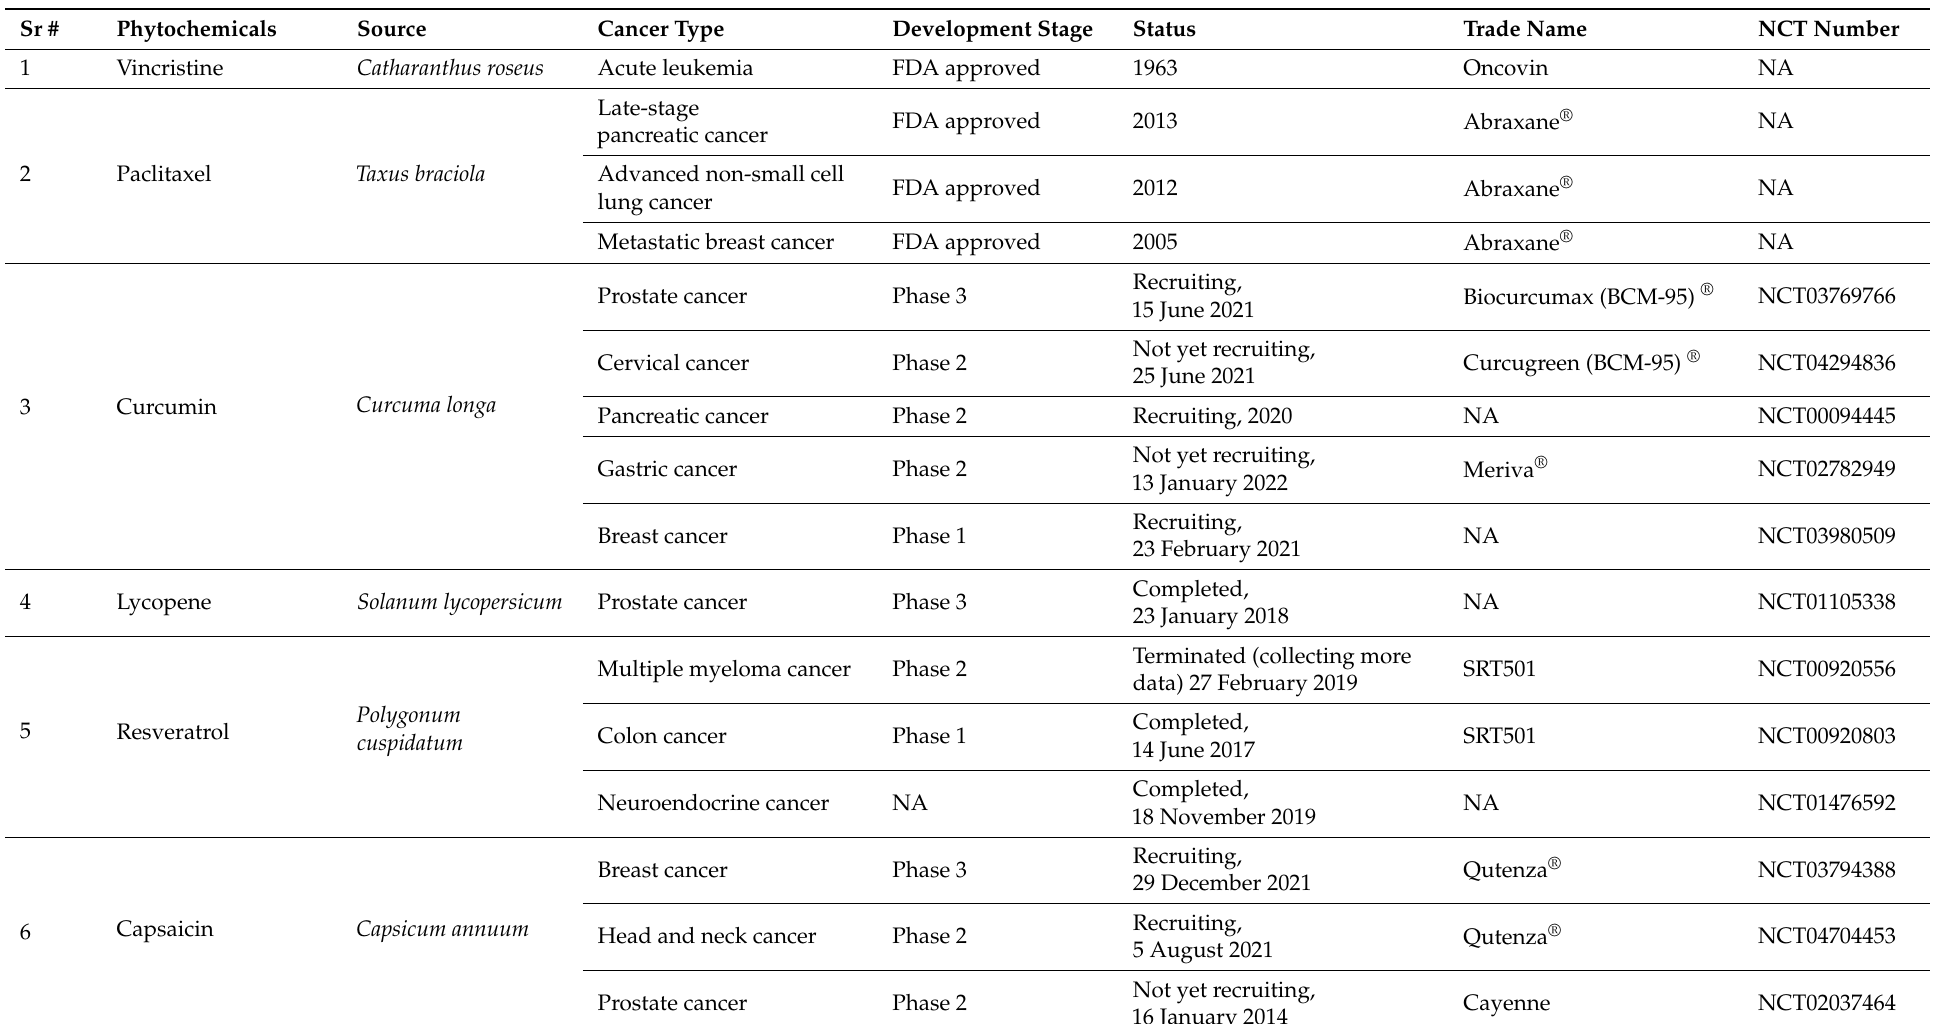
Table 5. List of phytochemicals approved by the FDA or in clinical trials for various types of